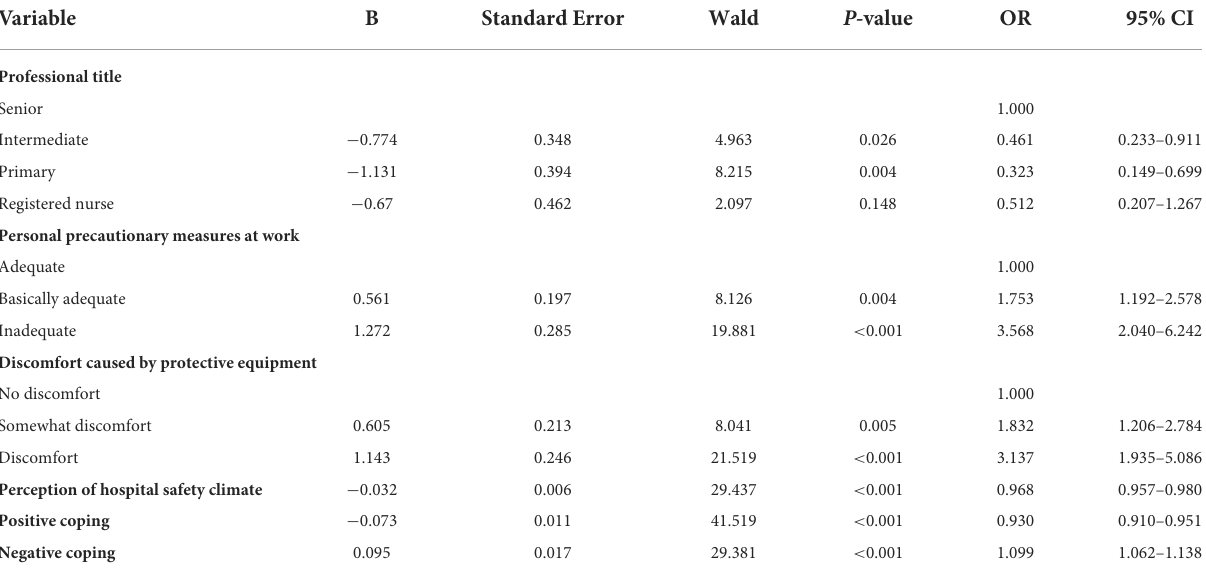
TABLE 4 Logistic regression analysis of psychological distress on